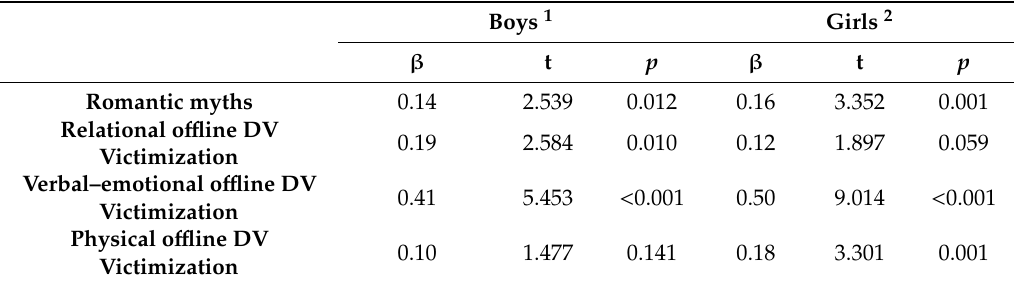
Table 3. Linear regression analysis for predicting Cyber-control victimization.